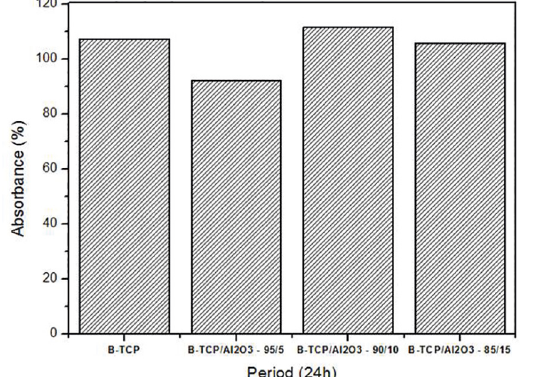
O scaffolds for 24 2 3